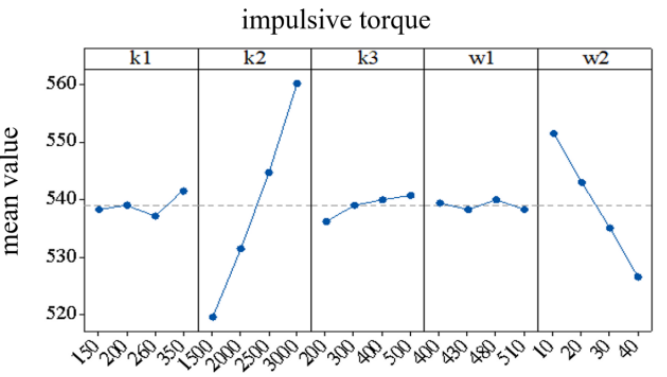
Figure 24. The influence of k1 on engagement time and impact Figure 24. The in fl uence of k1 on engagement time and impact torque.